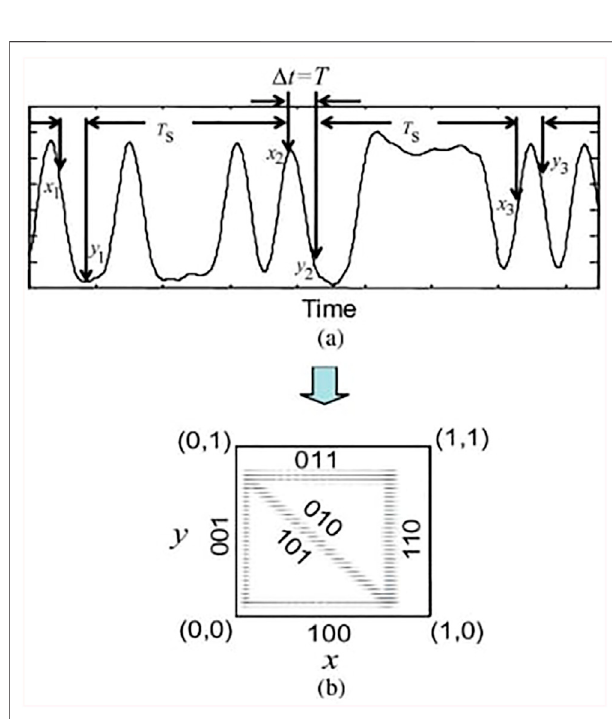
FIGURE 5 | Generation of phase portrait (Anderson T. B. et al., 2009).